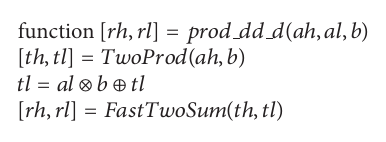
Algorithm 11: Multiplication of a double-double number by a double